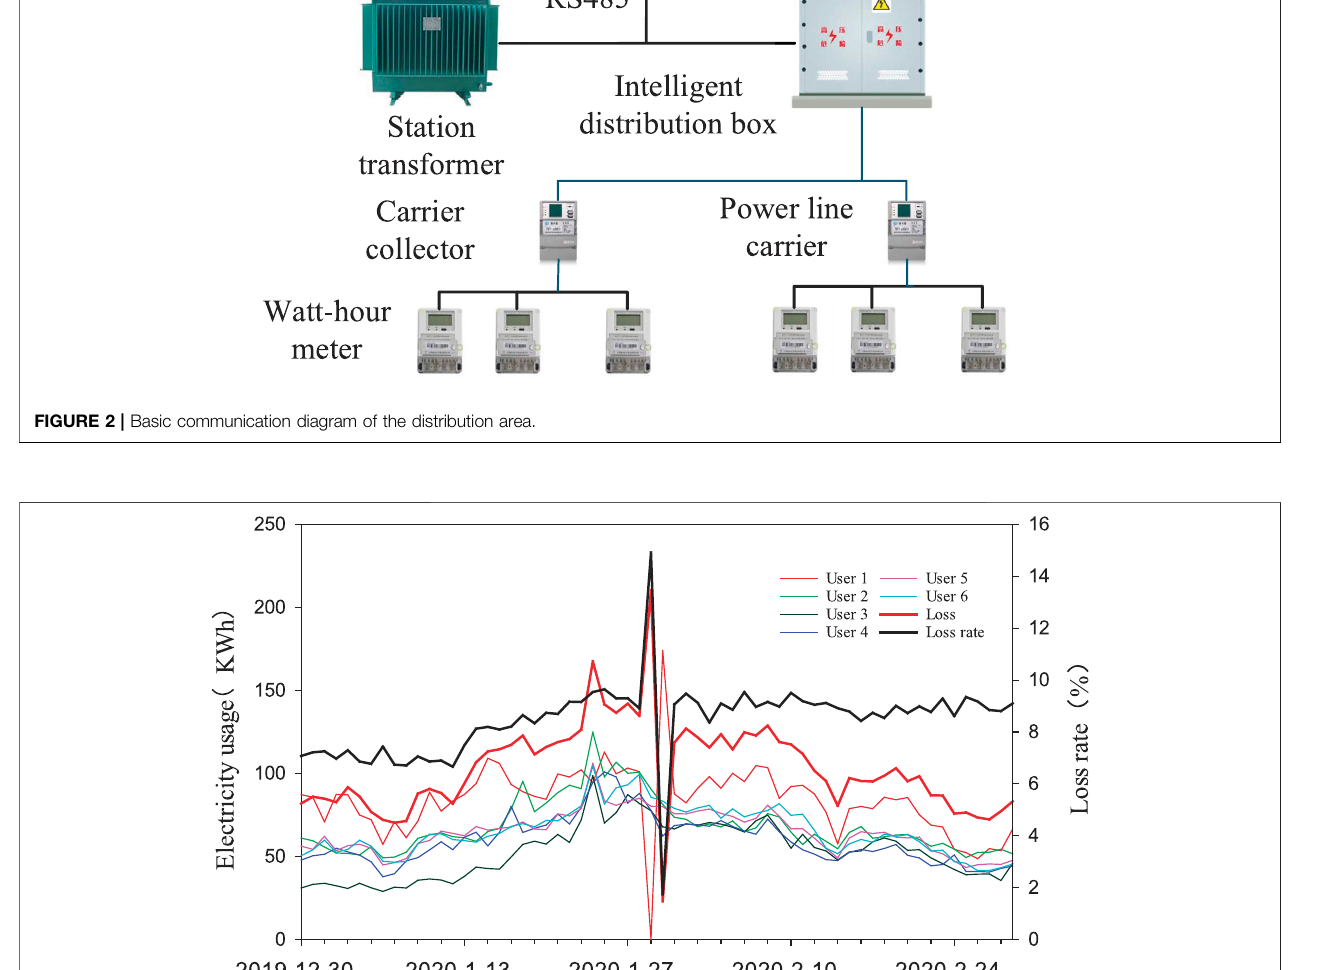
FIGURE 3 | Electricity usage of users and loss of DTSZ with communication